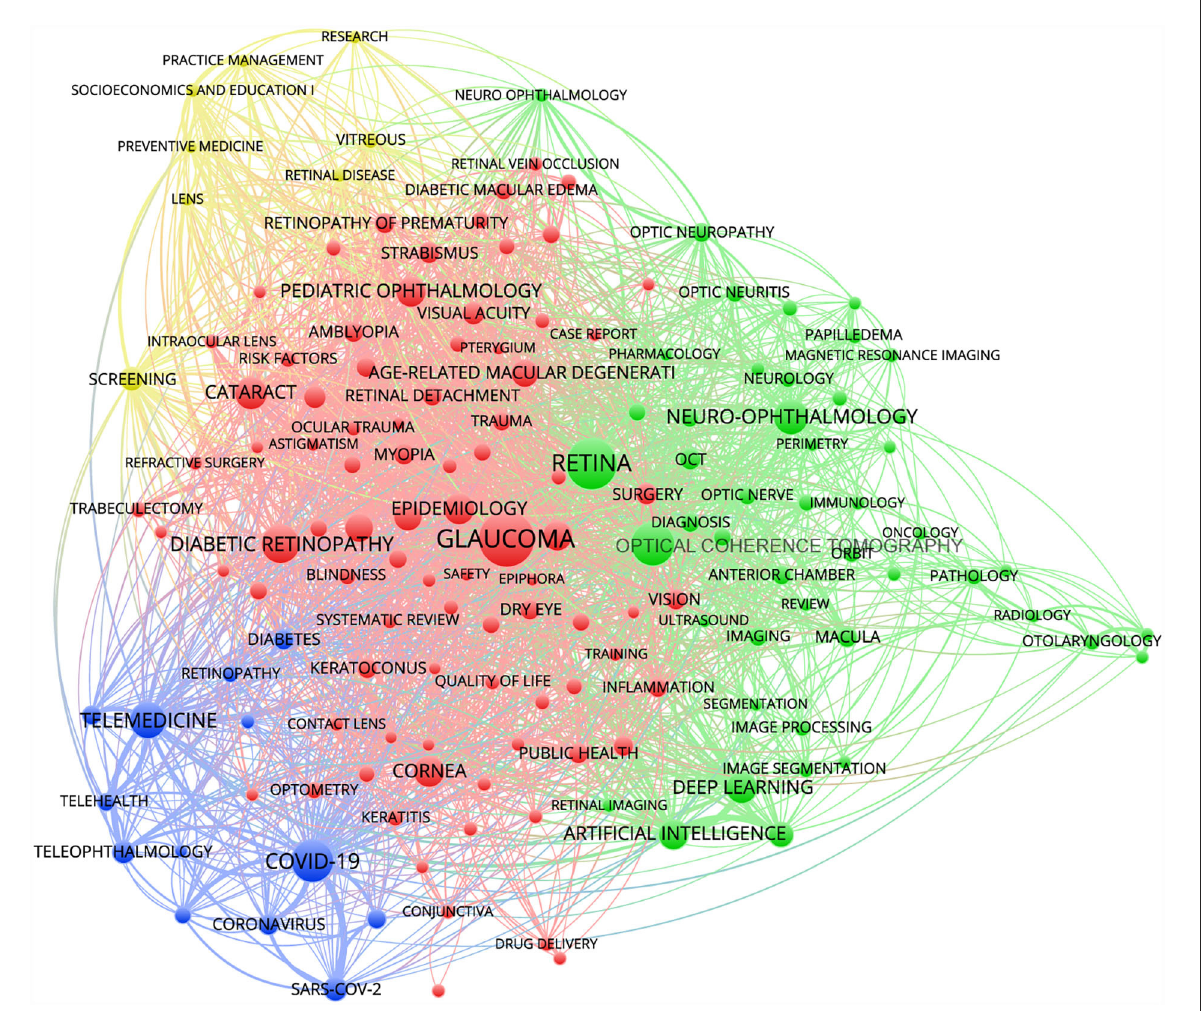
FIGURE2 Ophthalmology research hotspots analysis. The keywords formed four clusters, which were differentiated by color in the diagram, with the same color being the same cluster. The keyword size indicated the number of occurrences of the keyword, whereas the thickness and distance of the connecting lines between the keywords indicated the frequency of co-occurrence between the two